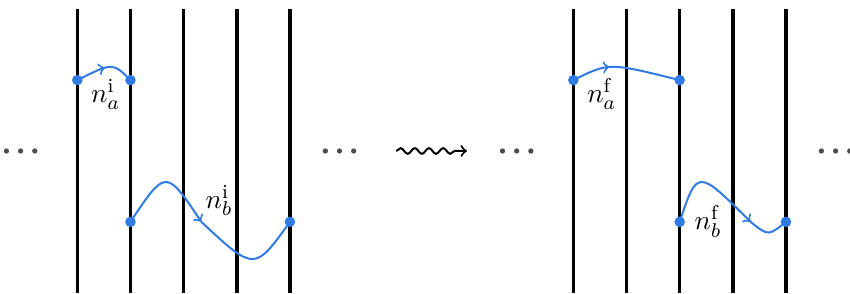
Figure 5. The vertical lines represent D-branes separated by the same distance L , and the blue wavy lines represent fundamental strings with their ends residing on different D-branes. The picture on the left represents the initial state and the picture on the right represents the final state of the scattering process. During the scattering process, the two strings join into one at the second D- brane from the left; then, the single intermediate string splits at the third D-brane into two. This picture captures the conservation law n 1 + n 2 + n 3 + n 4 = 0 , with n 1 = 1 , n 2 = 3 , and n 3 = n 4 = − 2 . The incoming strings on the left carry the initial quantum numbers n i outgoing strings on the right carry the quantum numbers n f for this type of scattering process is given by (3.14). The total number of D-branes involved in the scattering process is equal to n 1 + n 2 + 1 = 5 .